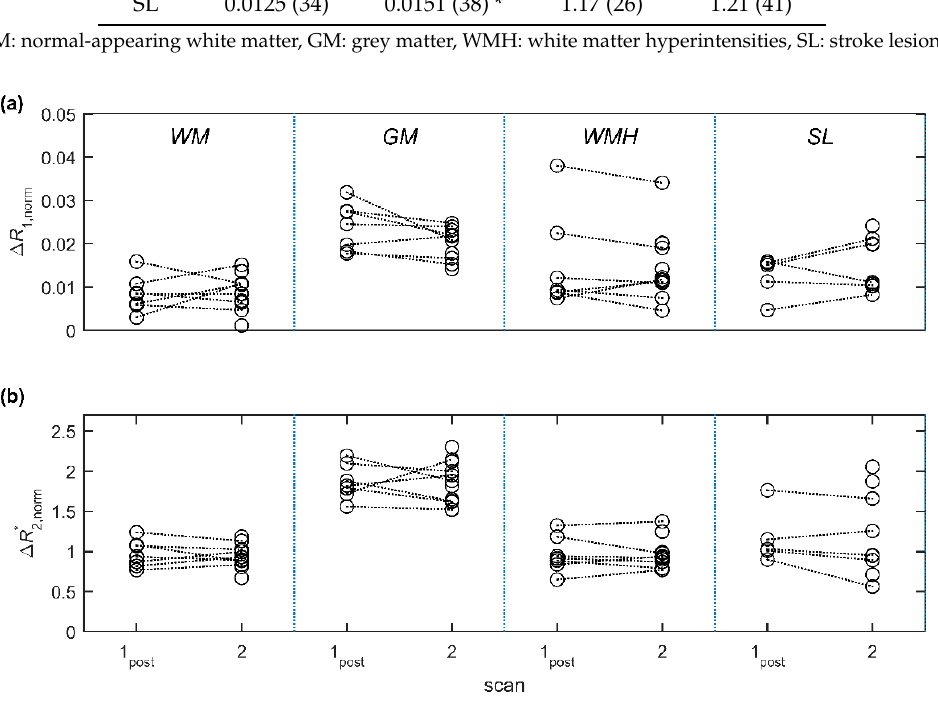
Figure 5. Blood-normalised relaxation rate changes ( a ) ∆ R 1,norm and ( b ) ∆𝑅 (cid:2870), norm ∗ at scan 1 post (immediately post-USPIO) and scan 2 (24–30 h post-USPIO). Changes are relative to baseline values measured at scan 1 pre (pre-USPIO) and are normalised to corresponding R 1 changes in blood. Values at scan 1 post are approximately equivalent ( ∆ R 1,norm ) or proportional ( ∆ R ∗ volume fraction, while values at scan 2 are potentially influenced by additional parenchymal